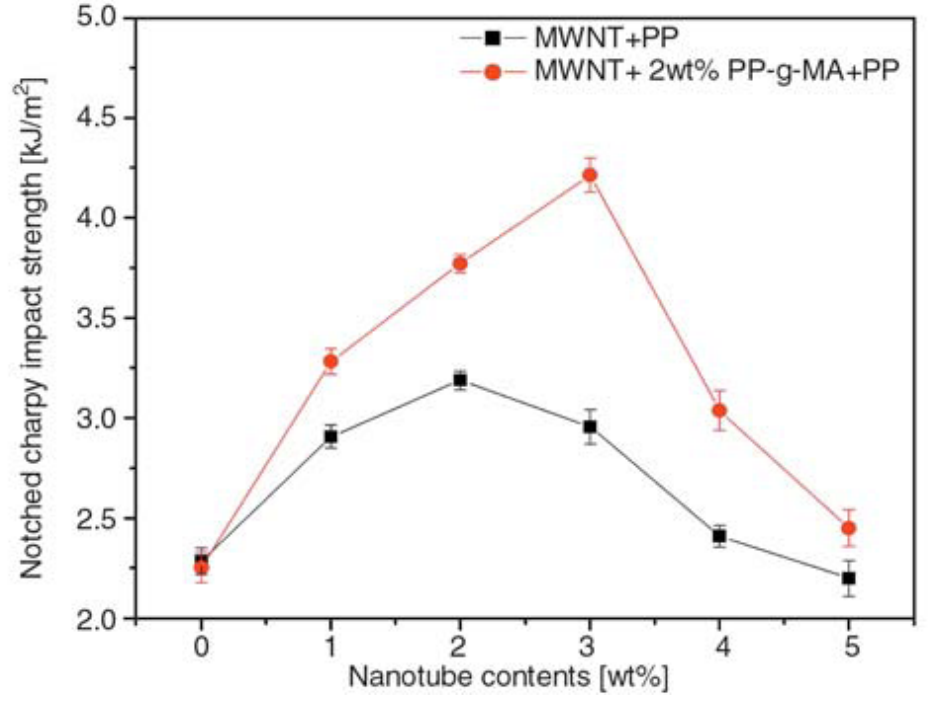
Figure 46. Impact properties of PP/MWCNTs (a) and PP/MWCNTs/2 wt % PP-g-MA (b) nanocomposites. Reproduced with permission from ref.